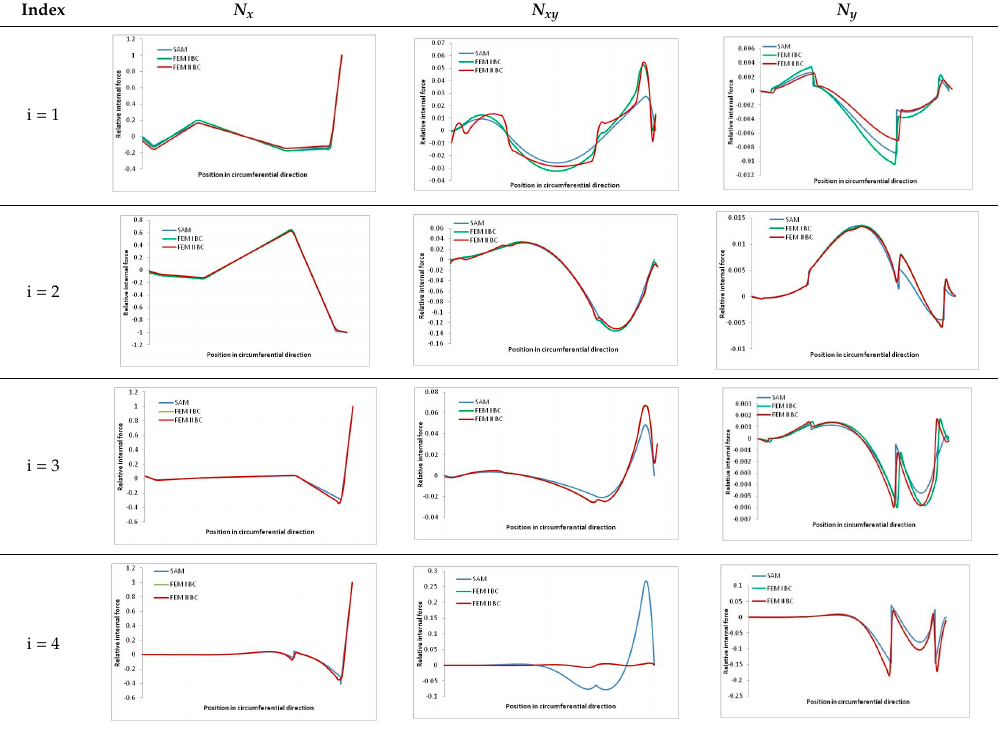
11 of 20 11 of 20